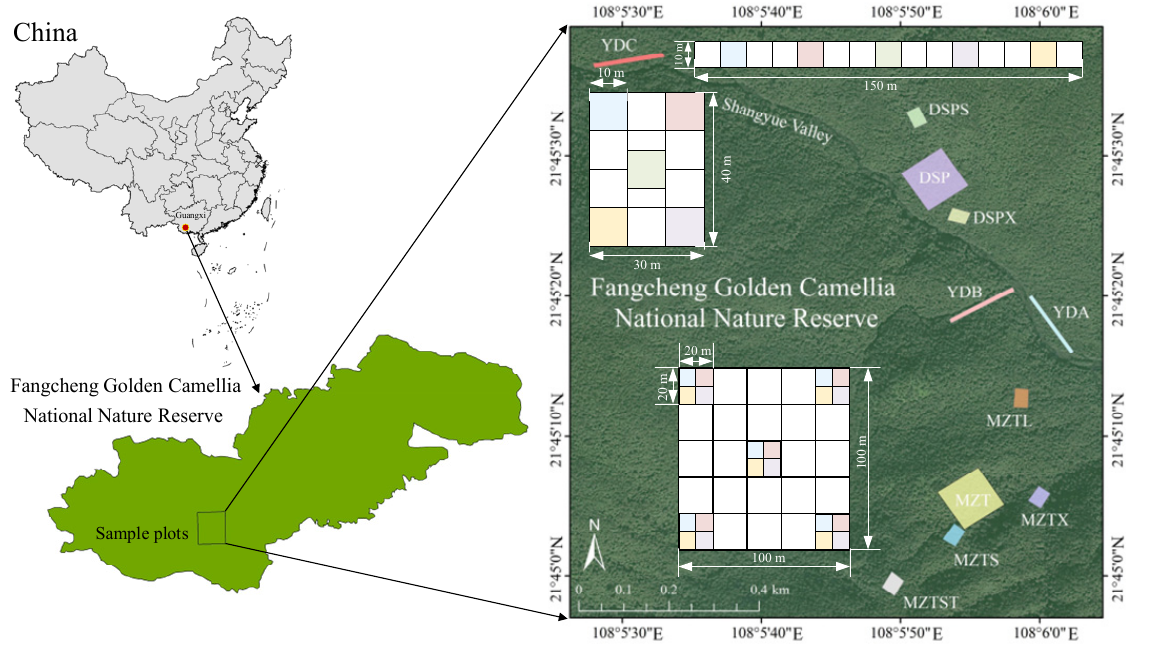
Figure 1. Location of the study area.